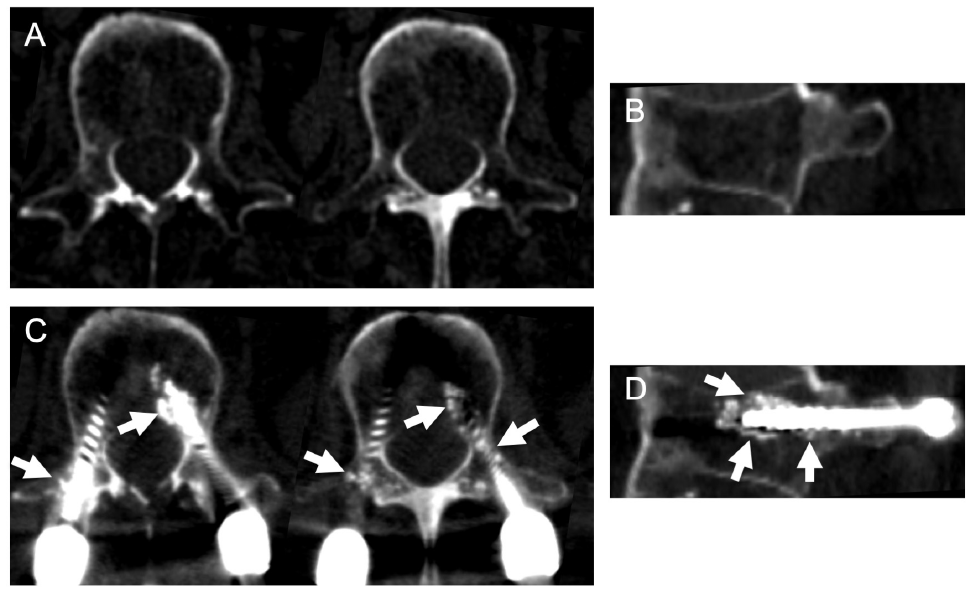
Figure 5. Computed tomography before ( A , B ) and after ( C , D ) surgery. Postoperative axial ( C ) and sagittal ( D ) images revealed that the HA granules surrounded the screws within the pedicle and vertebral body (Arrows).